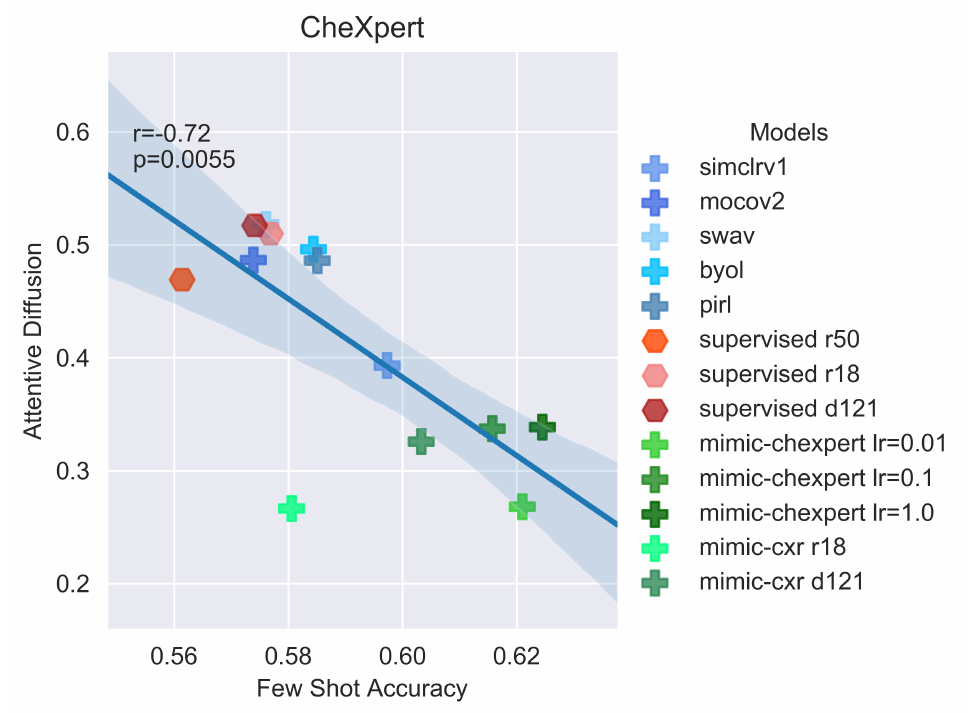
Figure 7. Few-shot accuracy on the CheXpert dataset plotted against attentive diffusion values for the reconstructed CheXpert image for all models. Shown overlaid are the Pearson’s r correlation coefficient and associated p value. A negative Pearson’s r close to − 1 (with a low associated p value close to 0) implies a strong negative correlation.